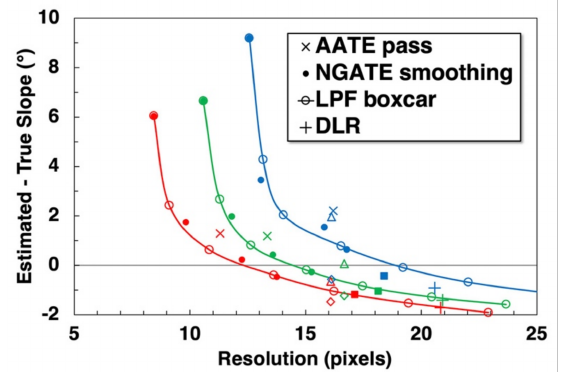
Figure 7. Error in RMS adirectional slope at 50 m baseline computed from various HRSC DTMs, compared to slope estimated from HiRISE data. Symbols indicate DLR Level 5 and various smoothed SOCET NGATE DTMs as in Figure 6. Results for ASP DTMs are also shown, with symbols as in Figure 8. Red, green, and blue colors correspond to rough, full, and smooth areas outlined in Figure